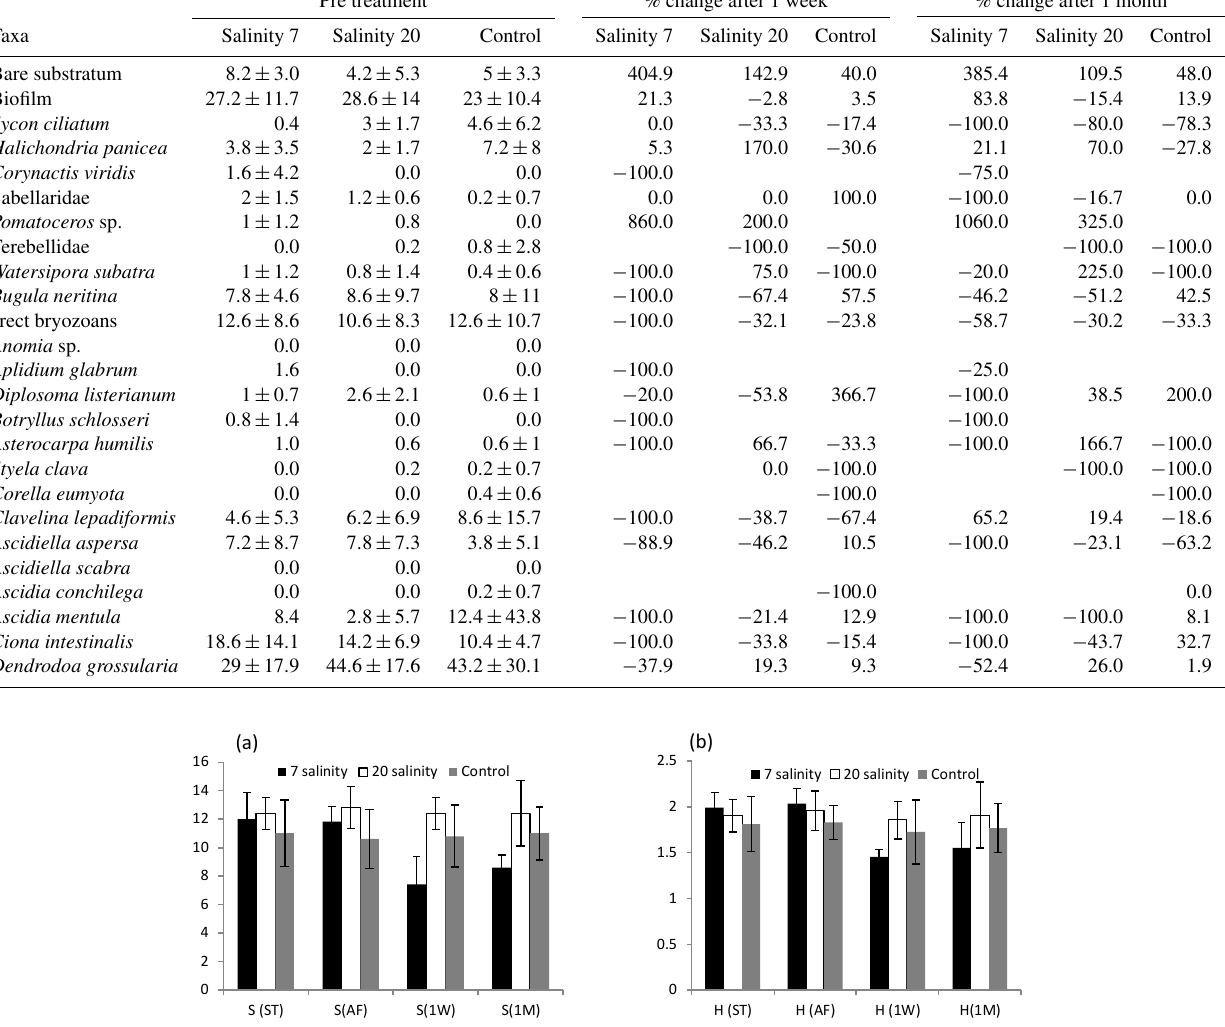
of organisms that were previously obscured, such as Poma- toceros sp. (Table